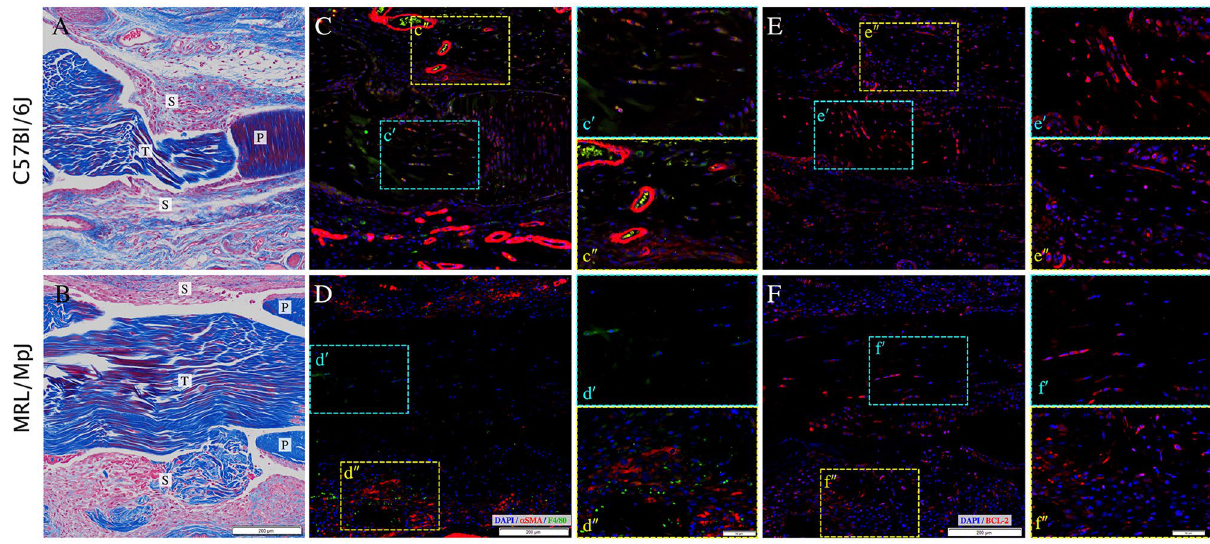
Figure 6. MRL Tendons heal with reduced myofibroblast and macrophage activation and reduced BCL2 expression at 7 dpi. Histology using Masson’s trichrome ( A , B ) and immunofluorescent (IF) staining against α-SMA+ myofibroblasts and F4/80+ macrophages( C , D ), and BCL-2 expressing cells ( E , F ) were performed on injured C57 and MRL tendons at 7 dpi. IF shows increased vascularization in the C57 scars and activated (α-SMA+) myofibroblasts and F4/80+ macrophages in both the injured C57 tendon and the surrounding scar tissue (Insets c ′ and c ′′ ). A subset of cells co-expressing both SMA and F4/80 in the injured C57 tendon (Inset c ′ ). Fewer α-SMA+ myofibroblasts and F4/80+ macrophages are observed but no localized expression of α-SMA and F4/80 is evident in the injured MRL tendon (Inset d ′ ), but SMA + myofibroblasts and F4/80+ macrophages were abundant in the surrounding scar tissue (Inset d ′′ ). BCL-2 expression was notably abundant in the injured C57 tendon (Inset e ′ ), but appeared to be reduced in the surrounding scar tissue (Inset e ′′ ) as well as in the MRL injured tendon and surrounding scar tissues (Insets f ′ and f ′′ ). Scale bars = 200 micron in main figures and 50 microns in insets. In panels ( A ) and ( B ), T denotes tendon, P denotes pulley, S denotes scar.